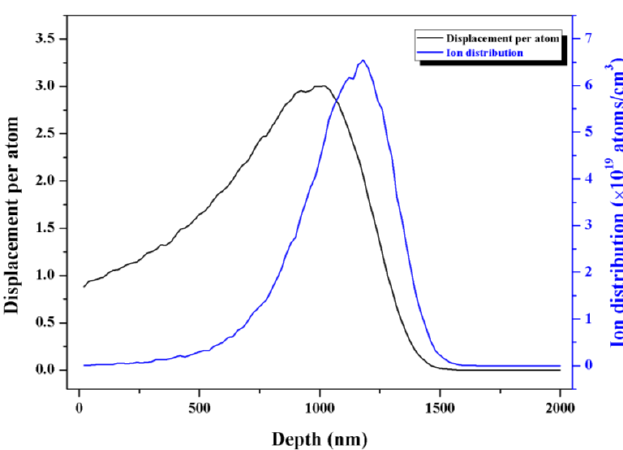
Figure 2. Depth profile of displacement per atom (dpa) and ion distribution in 3.5 MeV Fe 2+ ion irradiation.